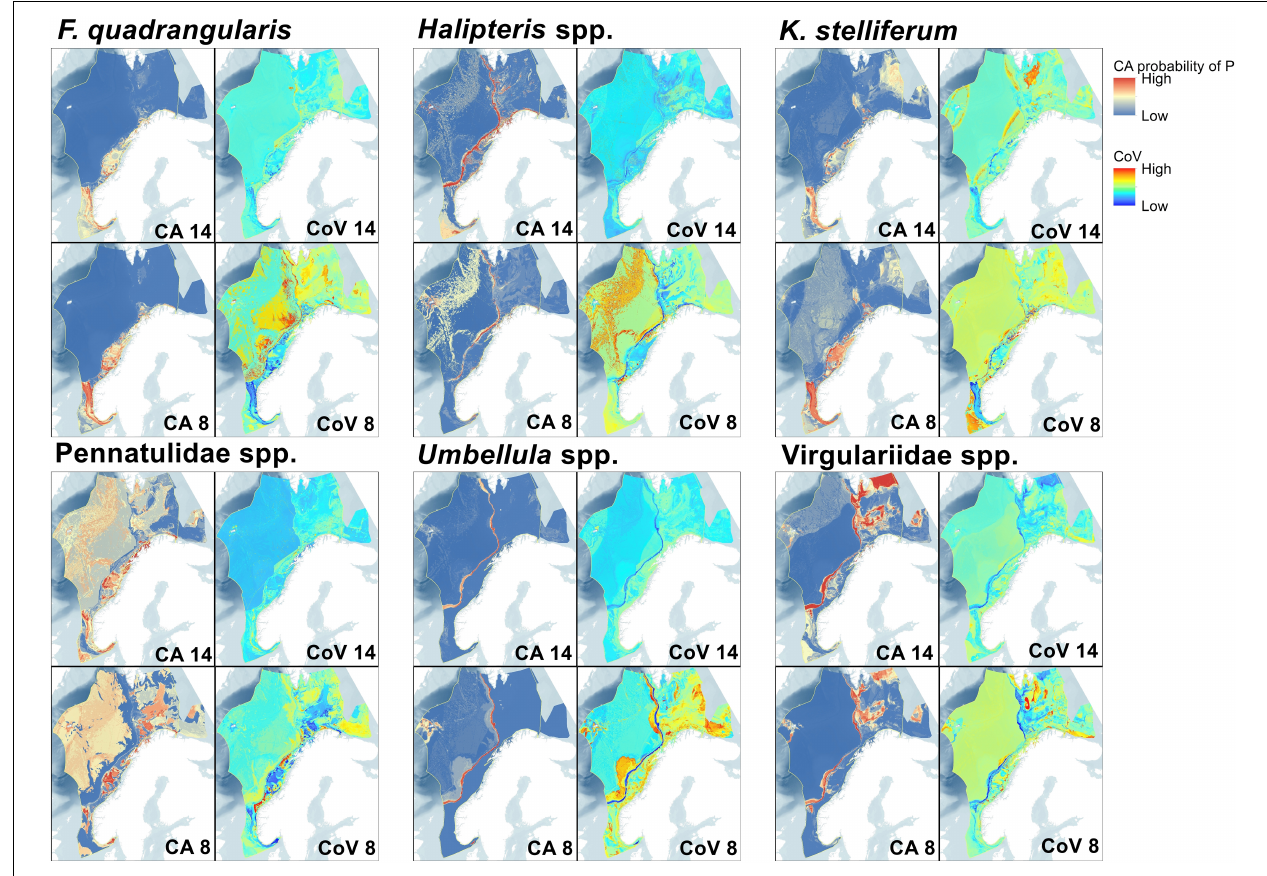
FIGURE 5 | Maps representing spatial uncertainty in predictions for both the fourteen and eight variable predictions. Committee averaged (CA) predictions combine prediction and uncertainty by averaging the likelihood of presence after conversion to a binary presence/absence prediction (here using the TSS score thresholds shown in Table 2 ), consequently these predictions include some measure of uncertainty as scores closer to 0 or 1 have greater consensus, while 0.5 shows disagreement. Coefficient of variation (CoV) displays the S.D./mean of all probabilities across models and therefore higher values show locations with greater variation in